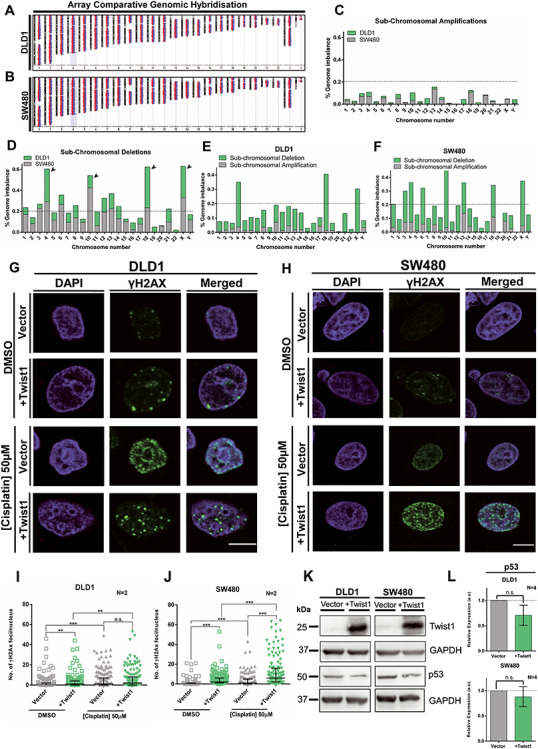
Twist1 overexpression induces sub-chromosomal deletions. (A and B) Chromosomal ideograms showing sub-chromosomal deletions and amplifications derived from array comparative genomic hybridisation (array CGH) for Twist1 overexpressing DLD1 and SW480 cells, respectively. (C) Sub-chromosomal amplifications quantified for each chromosome normalized to its total DNA content for DLD1 and SW480 cells. (D) Sub-chromosomal deletions quantified for each chromosome normalized to its total DNA content for DLD1 and SW480 cells. (E) Sub-chromosomal amplifications and deletions quantified for each chromosome normalized to its total DNA content for DLD1. (F) Sub-chromosomal amplifications and deletions quantified for each chromosome normalized to its total DNA content for SW480. The array CGH was from two independent biological replicates (N = 2, mean). (G) Representative mid-optical sections of DLD1 cells immunostained for γH2AX foci upon Twist1 overexpression upon DNA damage induction upon cisplatin treatment, vehicle control (DMSO), scale bar ~10 μm. (H) Representative mid-optical sections of SW480 cells immunostained for γH2AX foci upon Twist1 overexpression upon DNA damage induced upon cisplatin treatment, vehicle control (DMSO), scale bar ~10 μm. (I and J) Quantification of γH2AX foci in (I) DLD1 and (J) SW480 cells, respectively (Mann–Whitney test, N = 2, n > 130, Median-IQR, *P < 0.05, **P < 0.01, ***P < 0.001 and ****P < 0.0001, n: number of nuclei). (K) A representative immunoblot showing p53 levels upon Twist1 overexpression in DLD1 and SW480 cells. (L) Quantification of p53 protein levels from band intensities normalized to GAPDH (unpaired t-test, N = 4, mean ± SD, *P < 0.05, **P < 0.01, ***P < 0.001 and ****P < 0.0001), N: number of independent biological replicates.